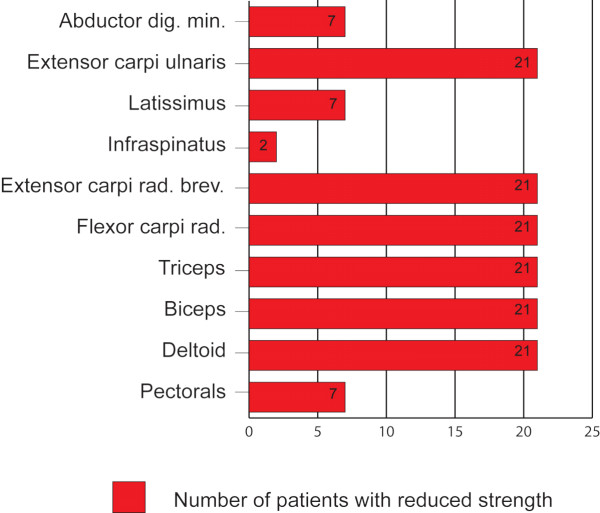
Strength reductions in 21 dominant limbs.